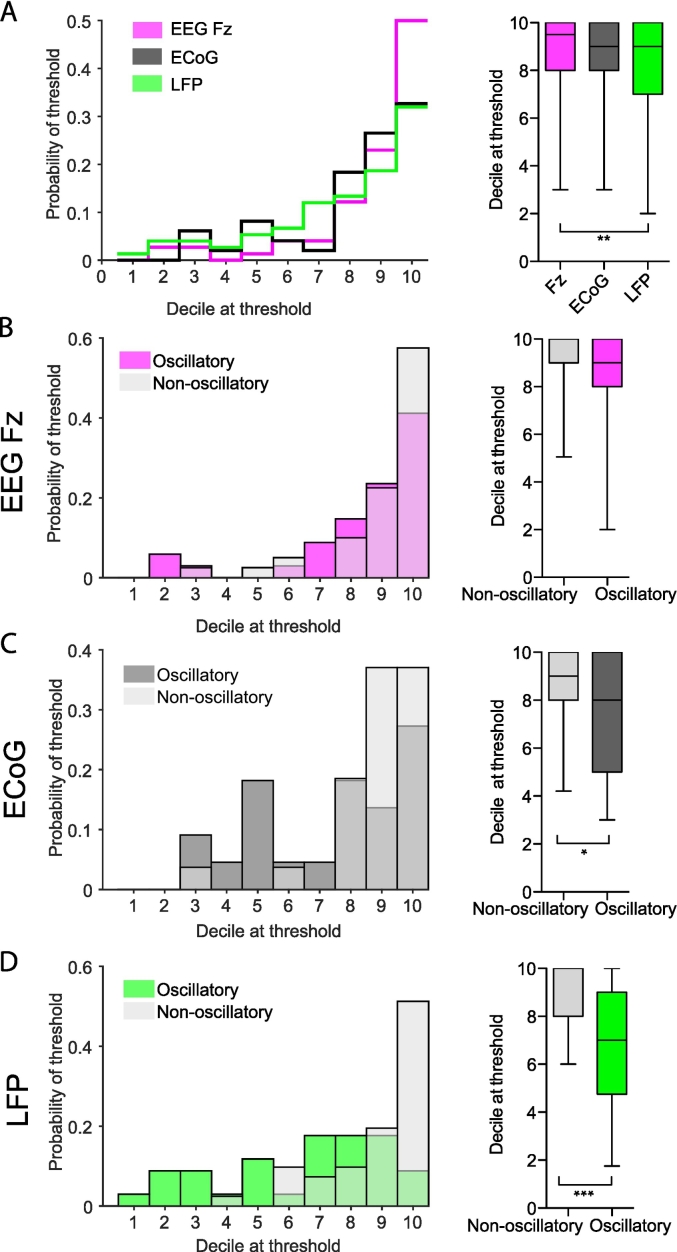
Non-oscillatory STN units require a higher magnitude of population oscillations to become significantly phase-locked. A, Left, distribution of the lowest decile in which each unit becomes significantly locked to the population oscillation. Note that the likelihood increases with decile number. Right, box plots for the distributions on the left. Note the median decile of first locking is the 8th. B-D, Left, distribution of lowest decile in which each unit becomes significantly locked to the population oscillations split into non-oscillatory and oscillatory units for Fz ((B), n = 40 non-oscillatory, n = 34 oscillatory), ECoG ((C), n = 27 non-oscillatory, n = 22 oscillatory) and LFP ((D), n = 41 non-oscillatory, n = 34 oscillatory). Intermediate colours indicate the overlap of the histogram between oscillatory and non-oscillatory units. Note that the threshold for non-oscillatory units to have significant phase locking is often the 10th decile, whereas the threshold for many oscillatory units is lower. Right, boxplots of the distributions on the left. Note the decile of first significant locking is higher for non-oscillatory units for all population signals, with a significant difference for ECoG and LFP. Pairwise comparisons were performed with MWUT, *** p < 0.001, *p < 0.05, whiskers of boxplots show the 5-95th percentile.